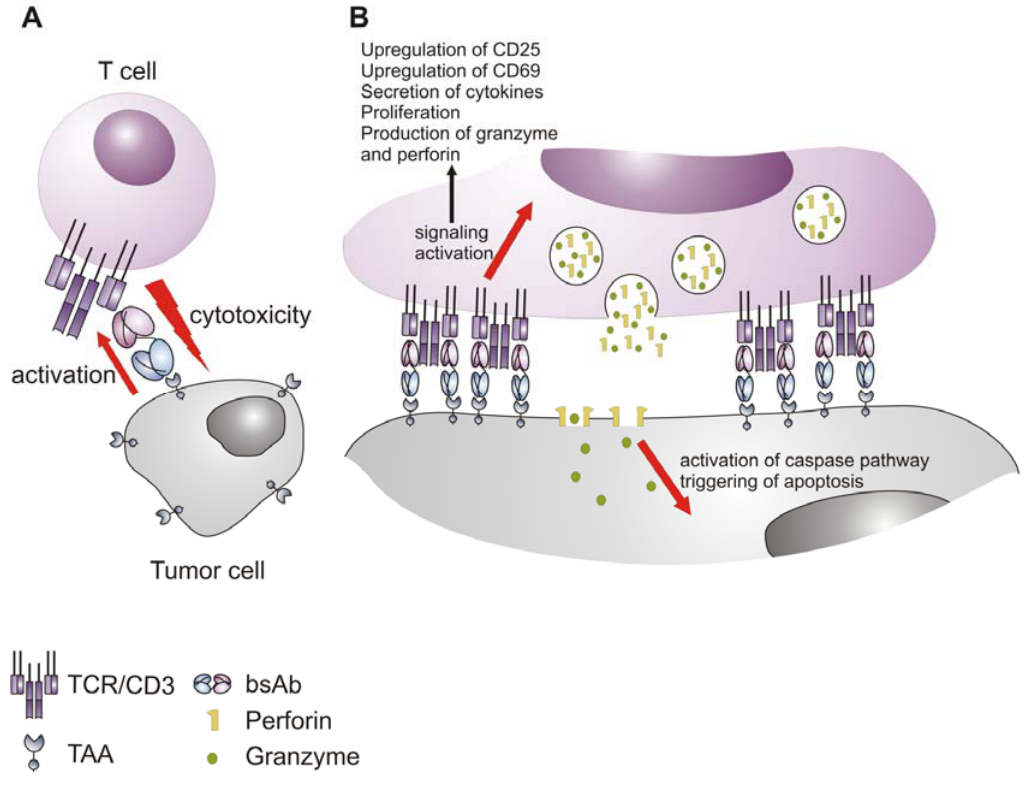
Figure 3. Mode of action of bispecific antibodies. ( A ) The bispecific antibody functions as an adaptor molecule between the T cell and the tumor cell, cross-linking the two cells and triggering CD3-mediated T cell activation, leading to lysis of the tumor cell; ( B ) The killing of the tumor cell is a result of the formation of cytolytic synapse, whereafter activated T cells release granules containing toxic payload of perforine and granzyme, which trigger apoptosis in the tumor cell. TCR: T cell receptor complex; TAA: tumor-associated antigen; bsAb: bispecific